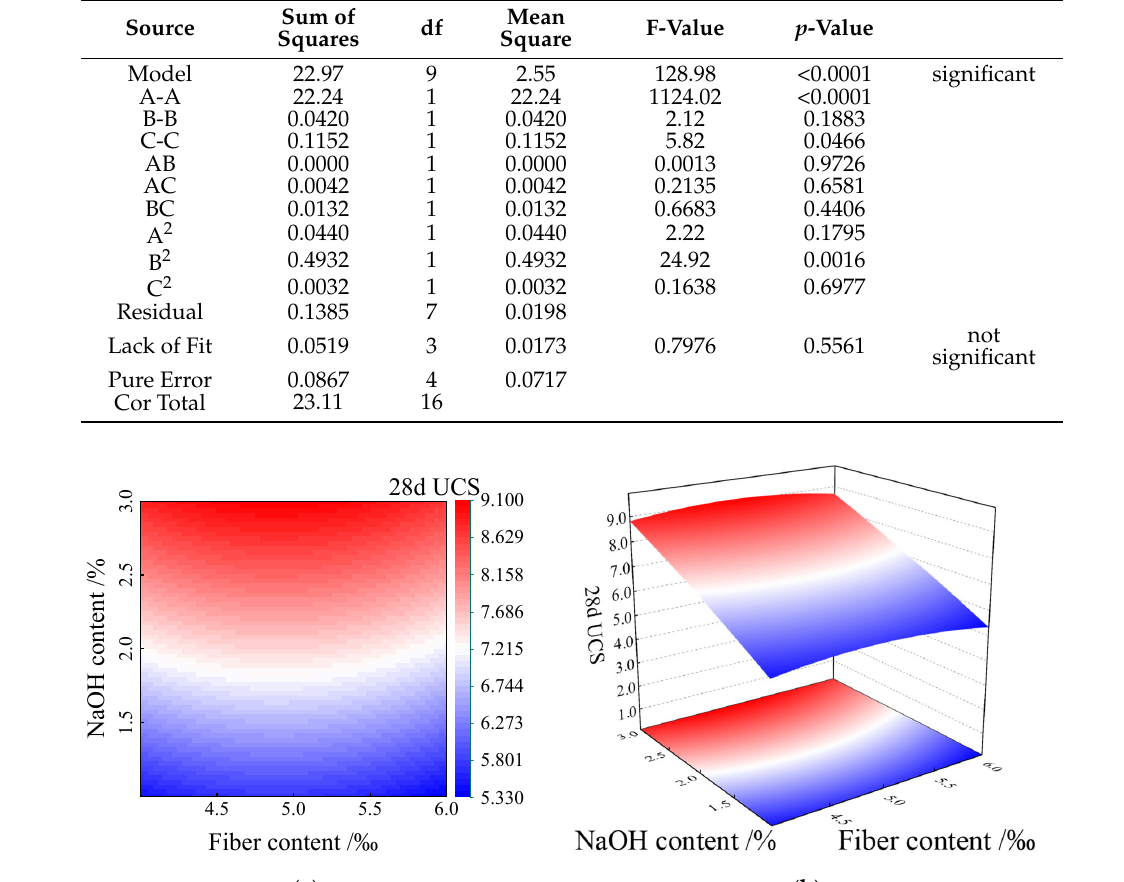
Table 8. Analysis of variance.